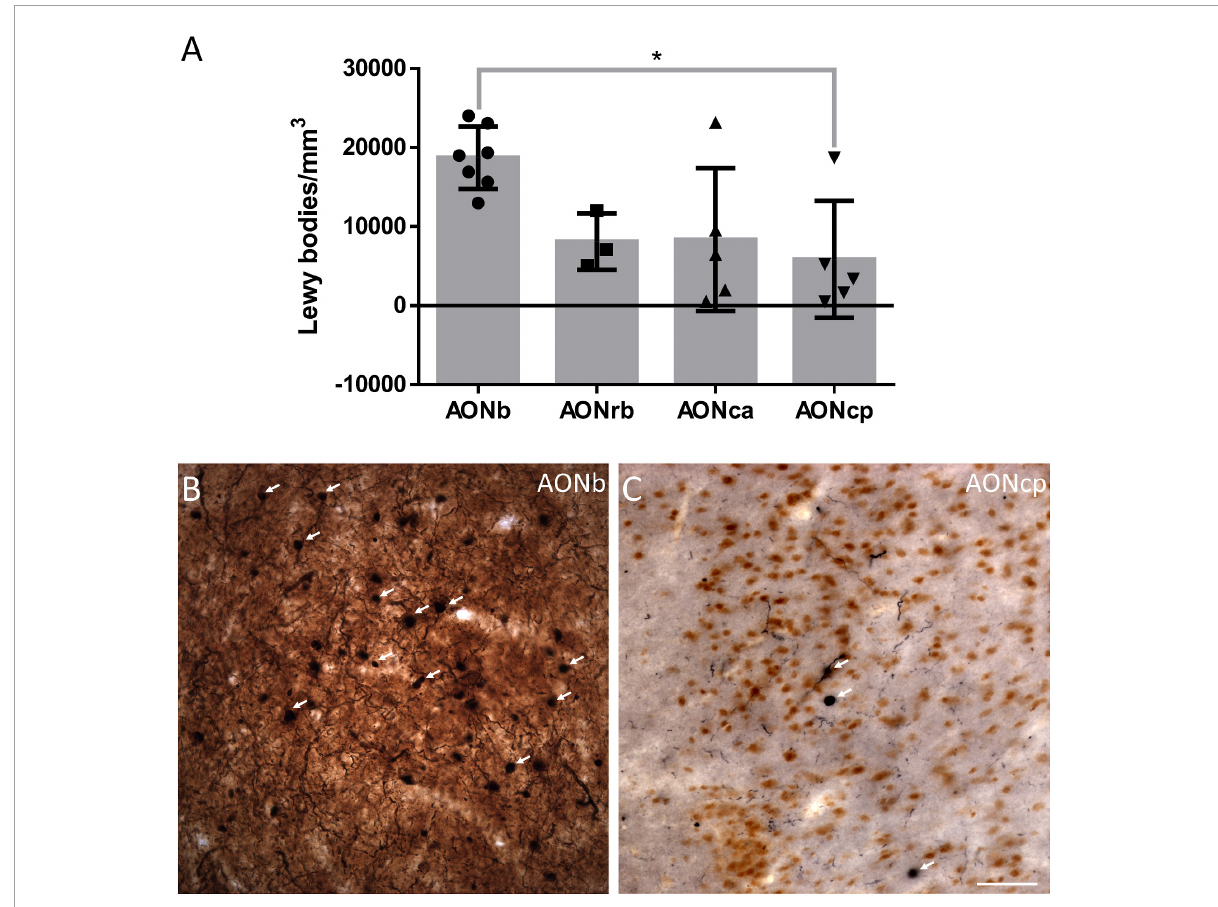
FIGURE4 α -synucleinopathy. The mean ± SD of the Lewy bodies density (A) . Immunohistochemistry against α -syn in AONb (B) and AONcp (C) . Arrows point to the LBs. * P -value <0.05. Scale bar = 25 mm.